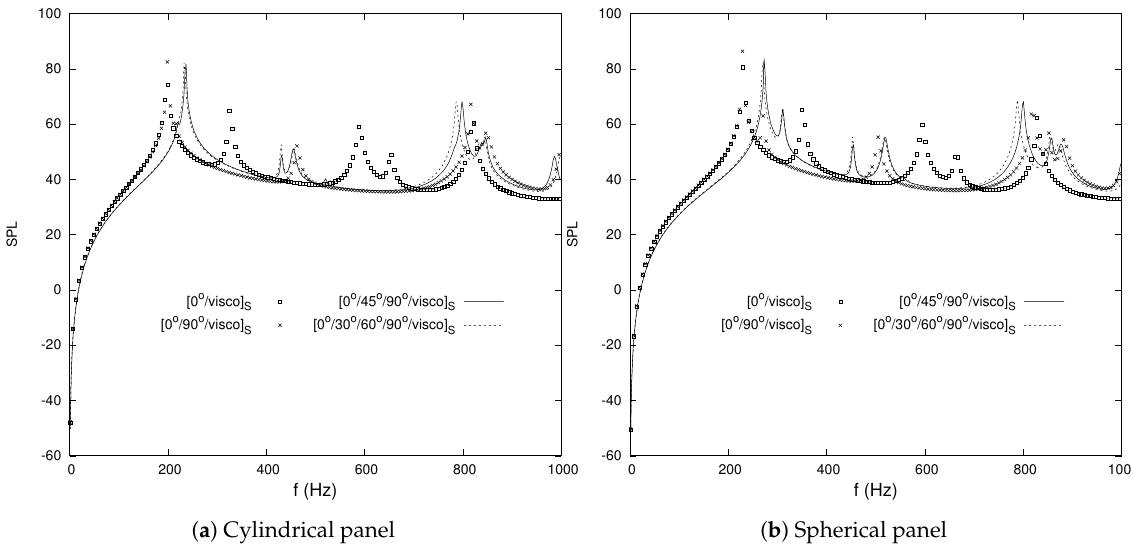
Figure 11. Transmitted sound power level ( SPL ) of the composite cylindrical and spherical shells with viscoelastic core, for different lamination